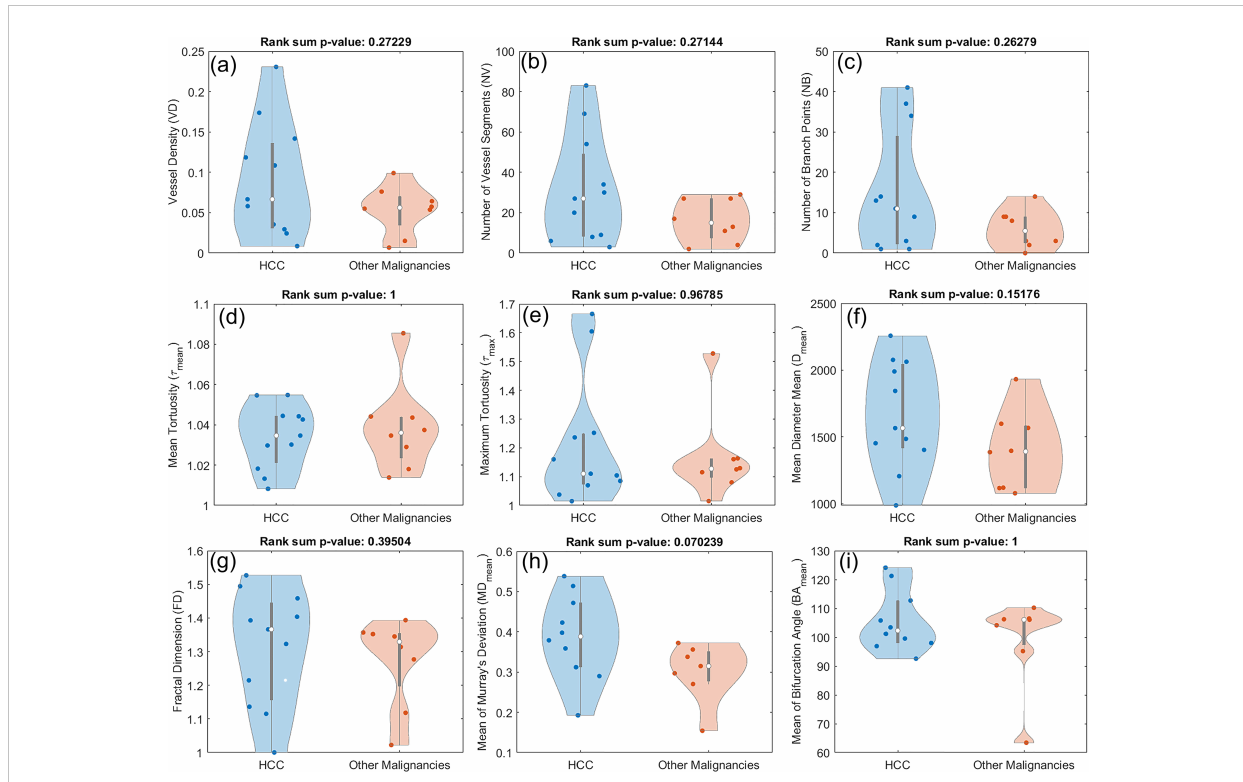
FIGURE 8 Composite boxplot/violin plots for all the utilized features in this study, comparing HCC with other malignant hepatic lesions (CCA and metastatic adenocarcinoma). None of the metrics proved distinctive between the two groups. (A) Vessel density ( VD ) (B) Number of vessel segments ( NV )